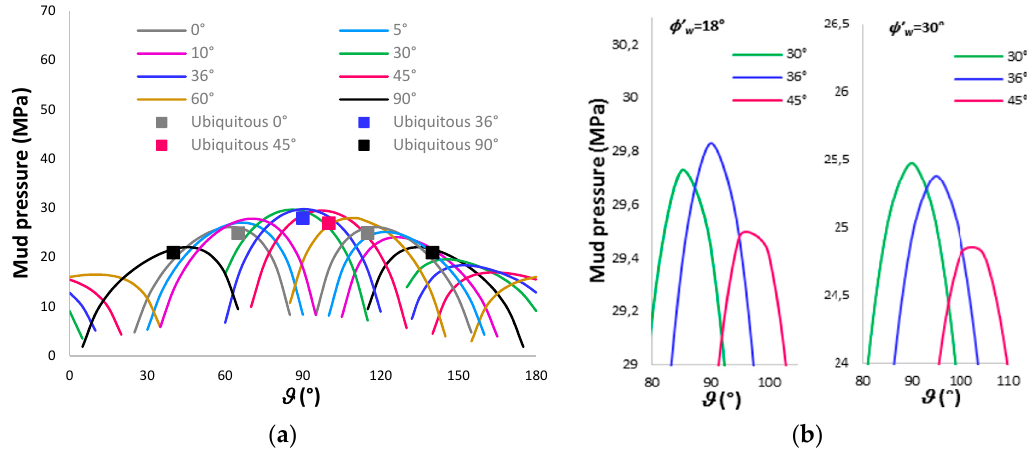
Figure 10. Mud pressures to prevent slip calculated with the weakness plane model at different δ . In situ stresses: σ MAX = 45 MPa, σ min = 35 MPa, P f = 20 MPa. ( a ) Comparison between the analytical approach (lines) and the numerical analysis with FLAC (filled symbols represent the occurrence of the first slip at the wall) for the Artificial rock: φ ’ w = 18° and c ’ w = 11 MPa. ( b ) Effect of the friction angle on the critical slip condition. The highest mud pressure occurs always at ϑ = 90° when δ = δ crit . Friction angle φ ’ w = 18° corresponds to δ = δ crit = 36° (blue line in the left side). Friction angle φ ’ w = 30° corresponds to δ = δ crit = 30° (green line in the right side).